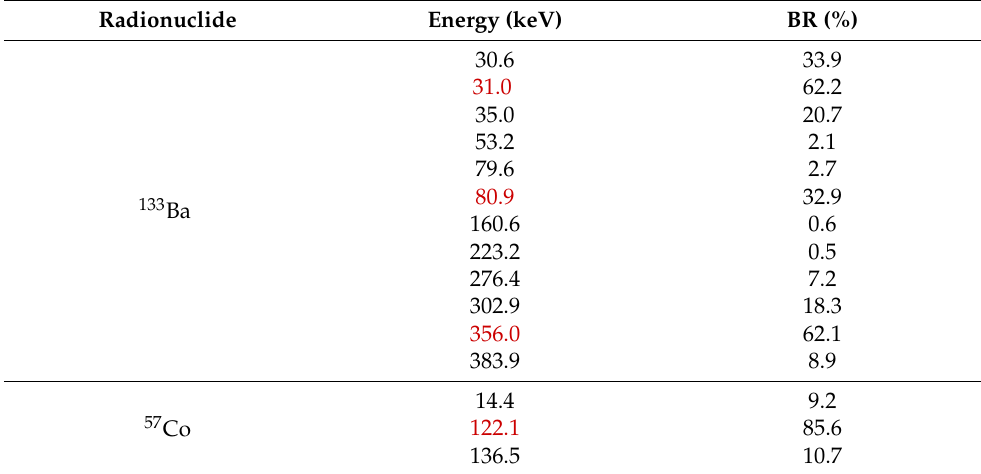
Table 1. 133 Ba and 57 Co X-ray and γ emissions along with their branching ratio. In red energies corresponding to higher intensities are highlighted.